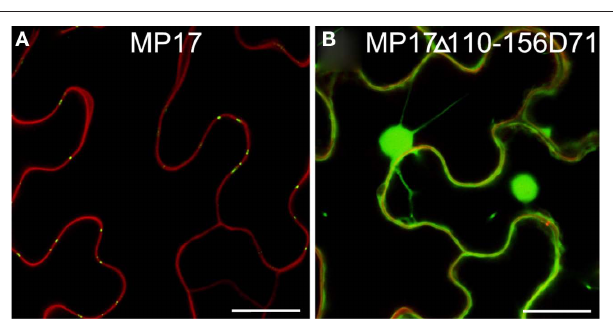
FiguRe 7 | Substitution of S71 by aspartate does not compensate loss of C-terminus. Confocal images of MP17 (A) or MP17 ∆ 110-156D71 (B) fusions in N. benthamiana epidermis cells; displayed are superimpositions of propidium iodide stained cell walls (red) and MP17:GFP fluorescence (green); bars represent